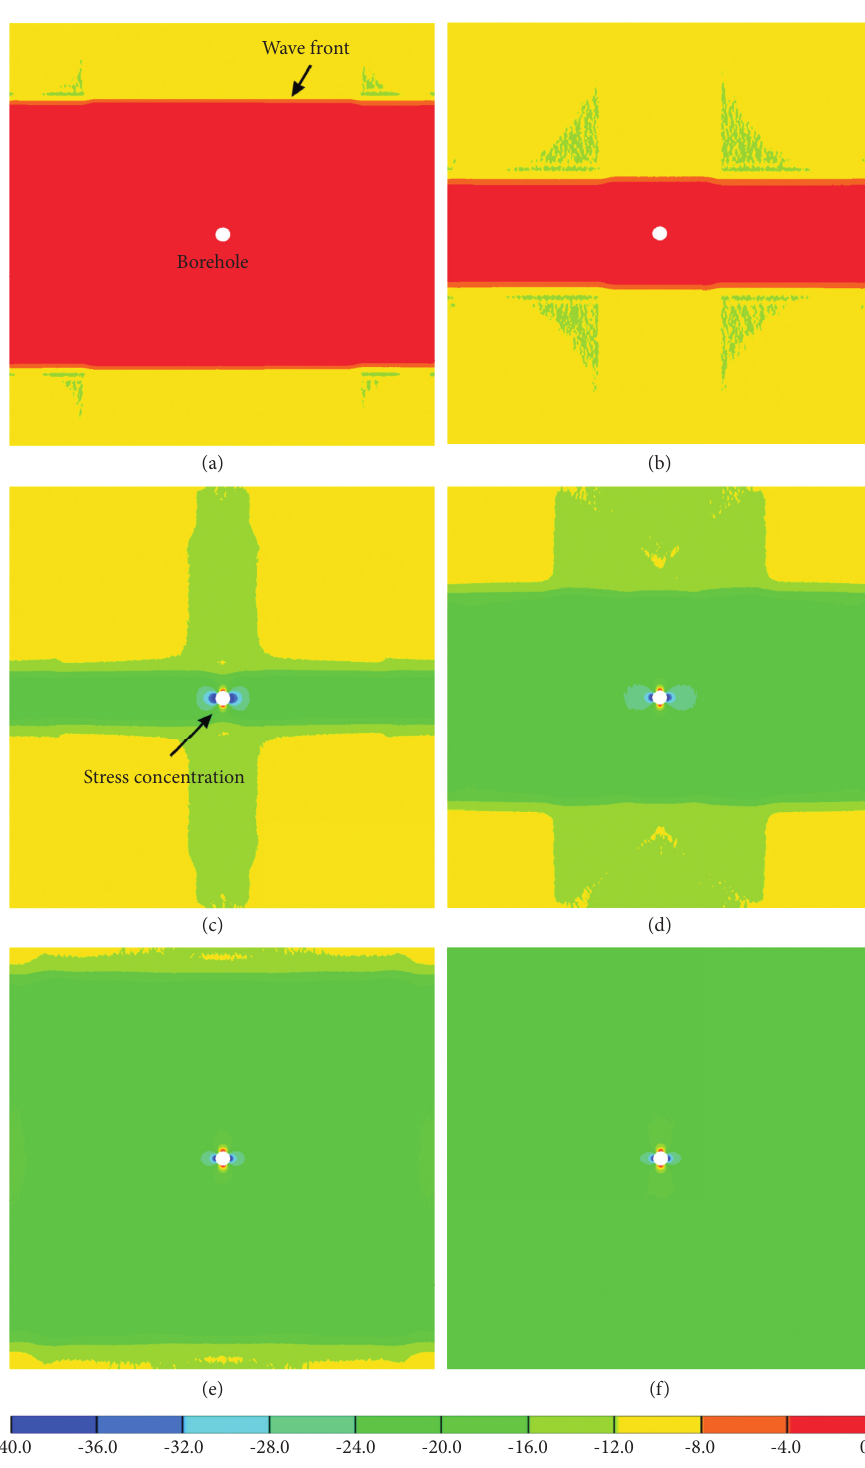
Figure 7: σ y distributions of the granite model as a function of time during stress initialization. (a) t (d) t � 33.18 μ s. (e) t � 41.48 μ s. (f) t � 49.78 μ